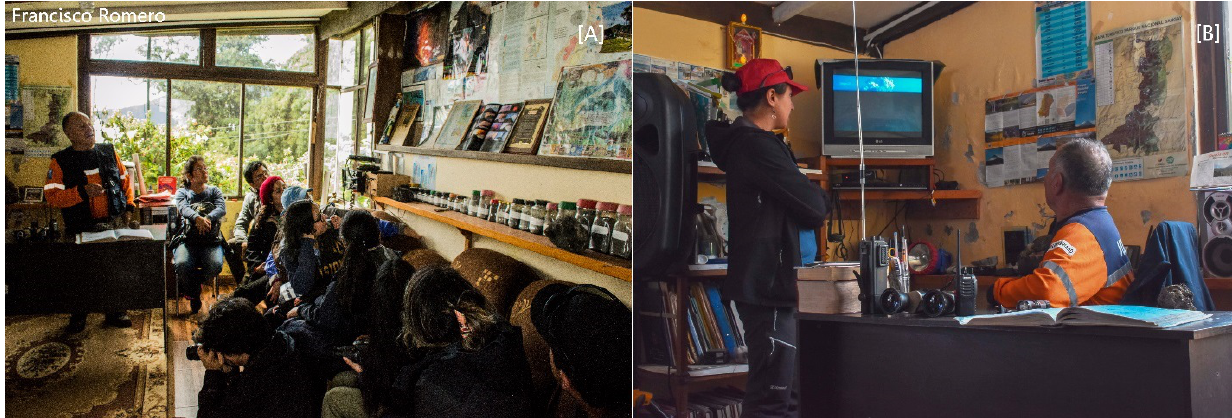
Figure 3: [A] Carlos Sánchez, a local “vigía” at Tungurahua Volcano, shares his experiences and [B] participants review footage from Tungurahua’s most recent activity.